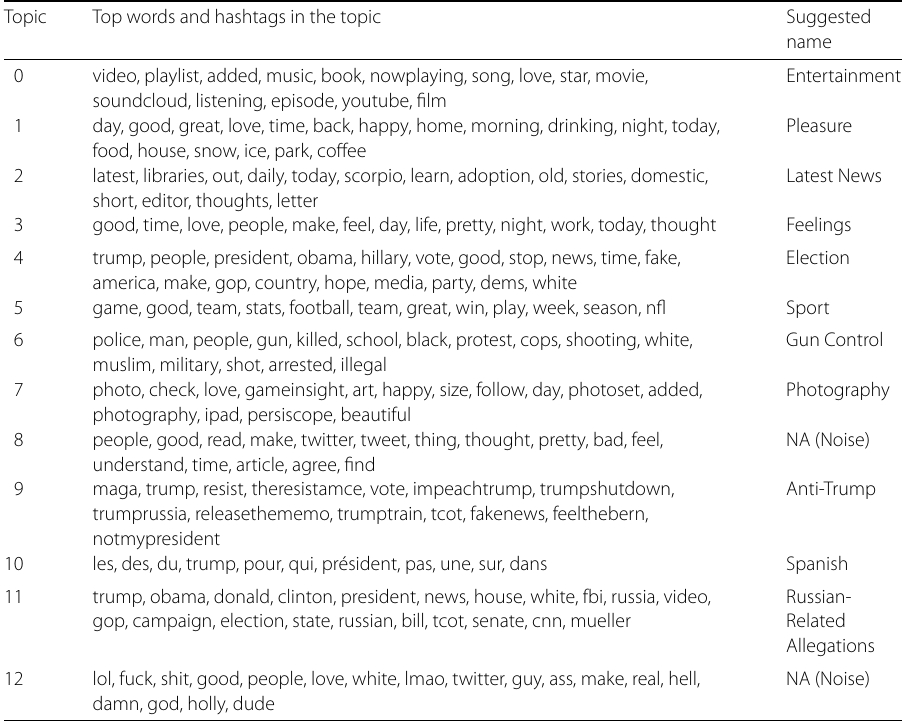
Table A3 List of the words in each tweet-LDA estimated topics along with their suggested potential